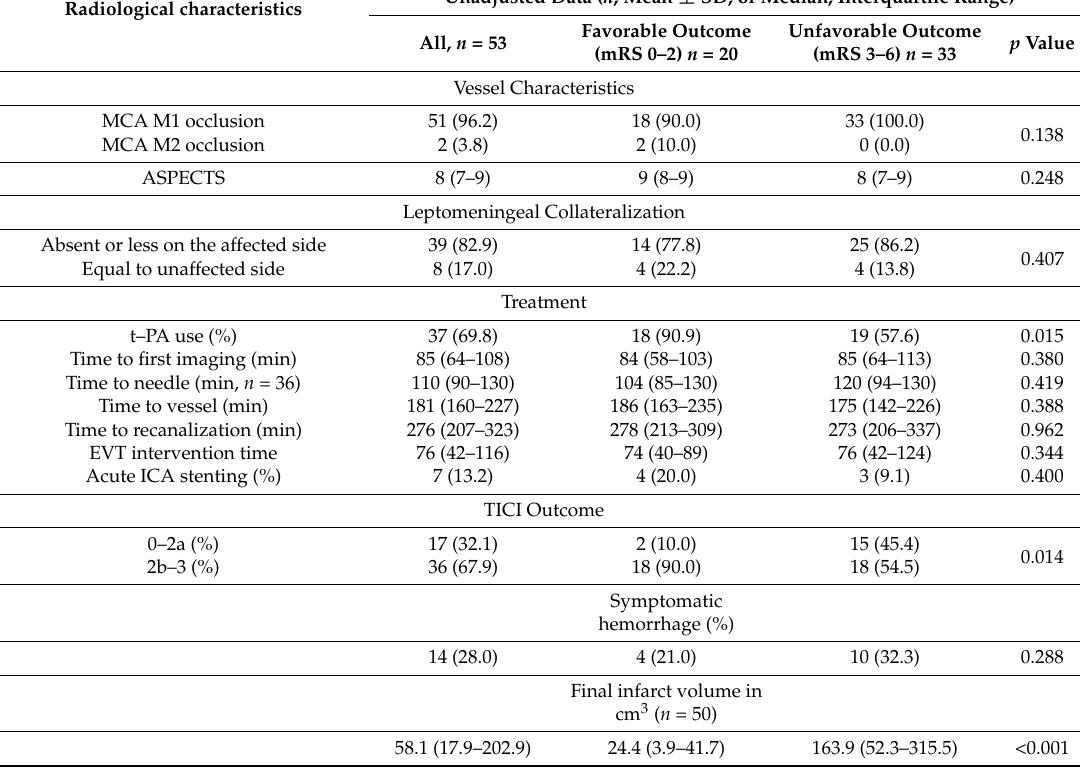
Table 2. Radiological characteristics of 53 patients with favorable and unfavorable outcomes following EVT for tandem internal carotid and middle cerebral artery occlusion.